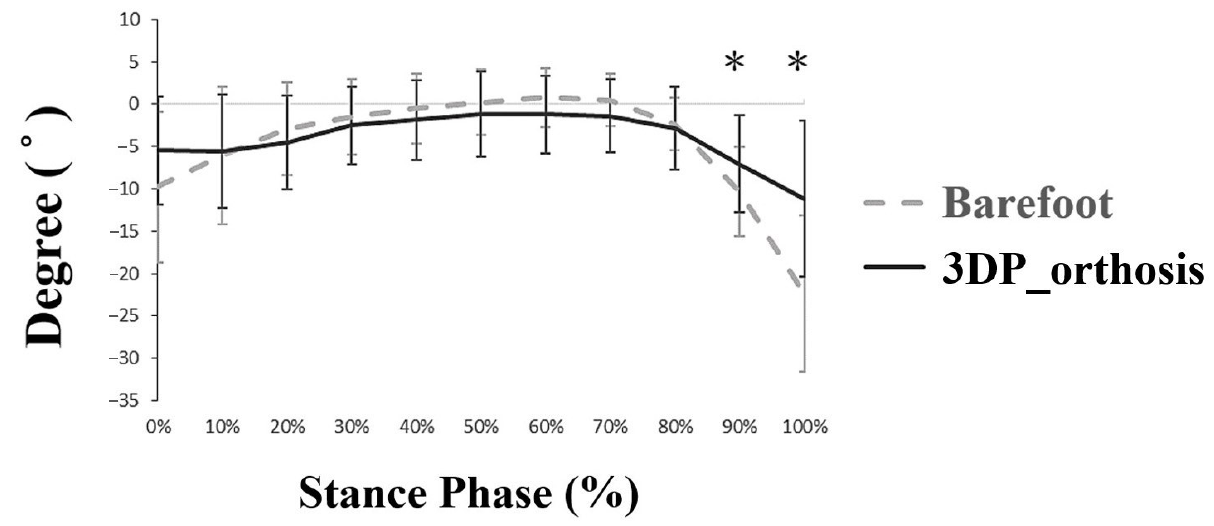
Figure 3. Variation in the abduction angles during the stance phase of gait. Note: “*”: significant difference; “+”: adduction; “ − ”: abduction.